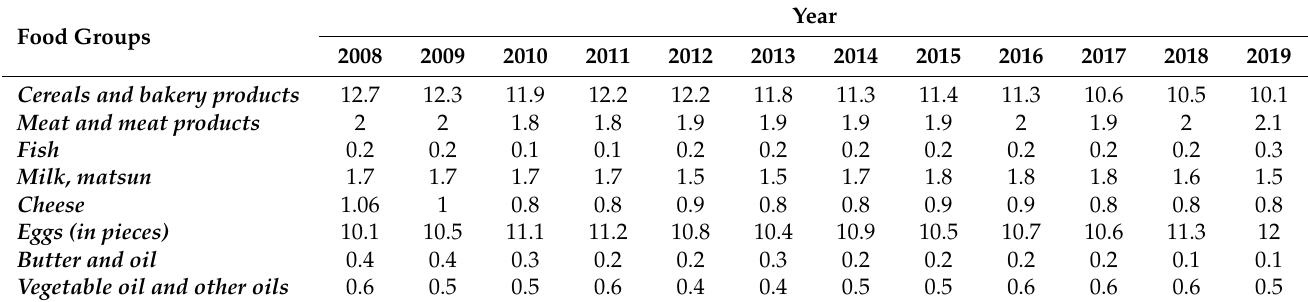
Table 2. Average Monthly Per Capita Consumption of Basic Food Products (kg/month).